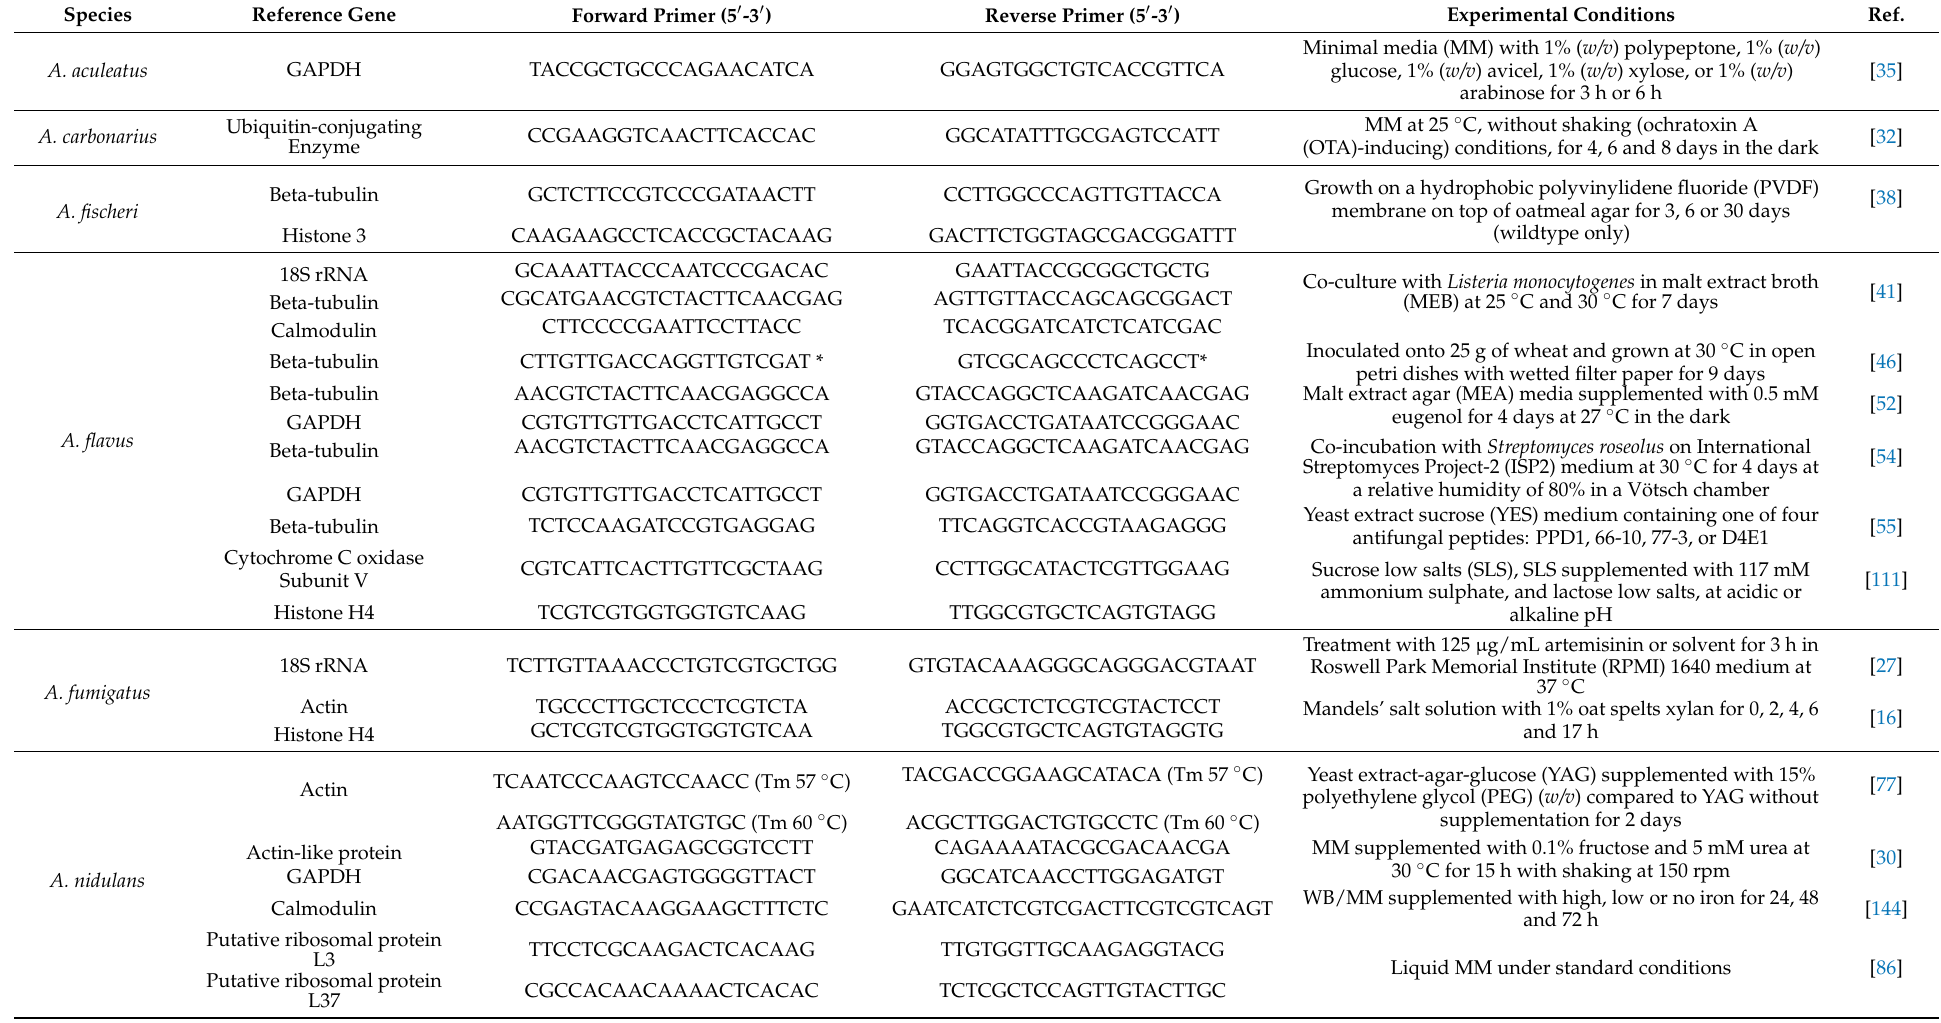
Table 2. Recommended reference genes for specific species and experimental conditions based on experimental